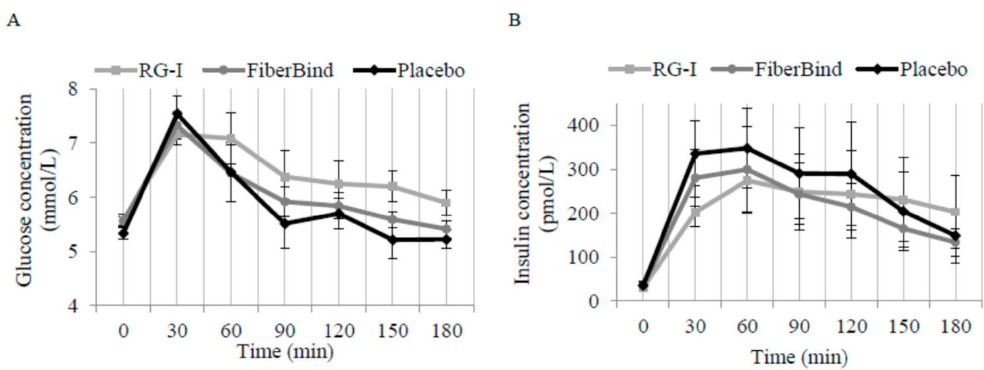
Figure 4. Mean ± SEM three-hour repeated measurements in a random subsample ( n = 9) of ( A ) glucose concentrations and ( B ) insulin concentrations. Mean postprandial glucose was higher after RG-I compared to FiberBind ( p < 0.01) but not the control. Insulin concentration was higher at 180 min after RG-I compared to the control ( p < 0.05). Time to peak for glucose was delayed with the RG-I ( p < 0.0001) and FiberBind ( p < 0.05), compared to the control, and peak insulin concentration was also lower with RG-I ( p < 0.01) and FiberBind ( p < 0.05). Abbreviations: RG-I, rhamnogalacturonan I.